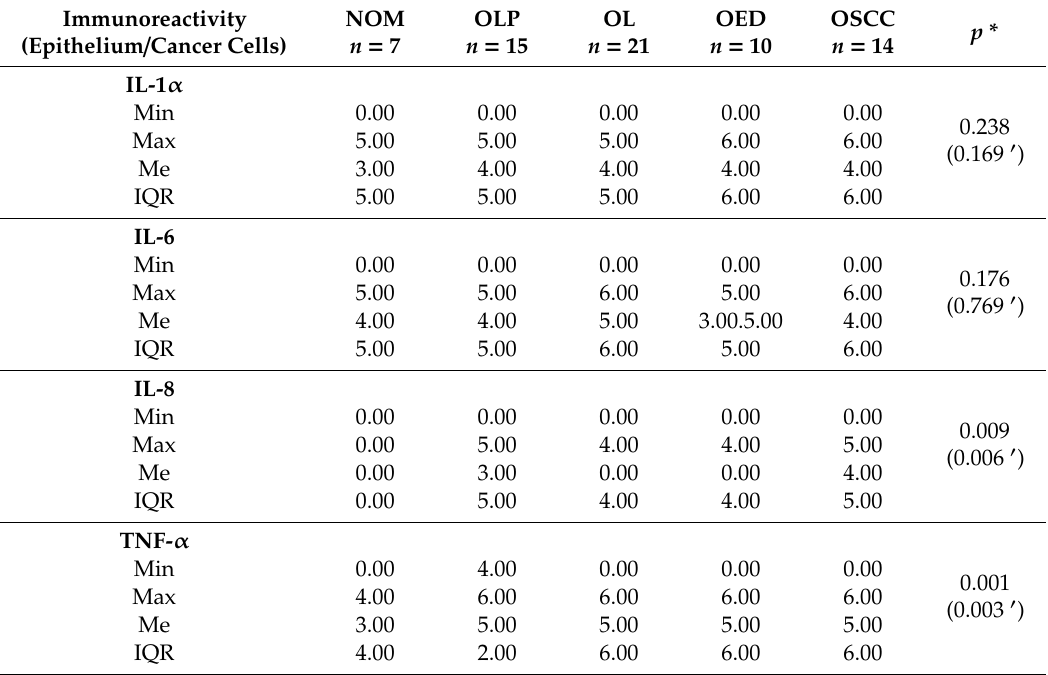
Table 3. Immunoreactivity for particular cytokines in epithelium / cancer cells.